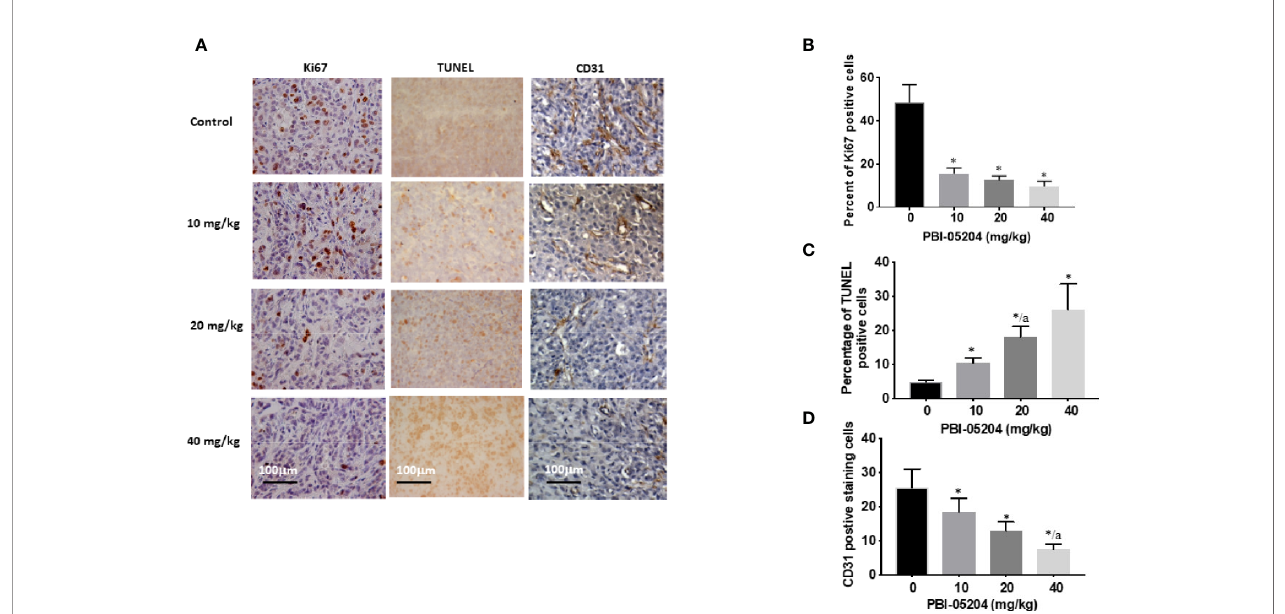
FIGURE 7 | Immunohistochemical staining of U87 tumor sections for proliferation (Ki67), apoptotic (TUNEL) and vasculature markers (CD31) (A) and quantitative analysis of the expression of Ki67 (B) , TUNEL (C) , and CD31 (D) . Data are presented as mean ± SD. Statistical analyses was carried out with the ANOVA determination followed by Tukey test. *p < 0.05 versus control for (B) , (C) , and (D) . No difference was found in the comparisons between different doses of PBI- 05204 in (B) . a p < 0.05 versus 10 mg/kg both in (C) and (D) .